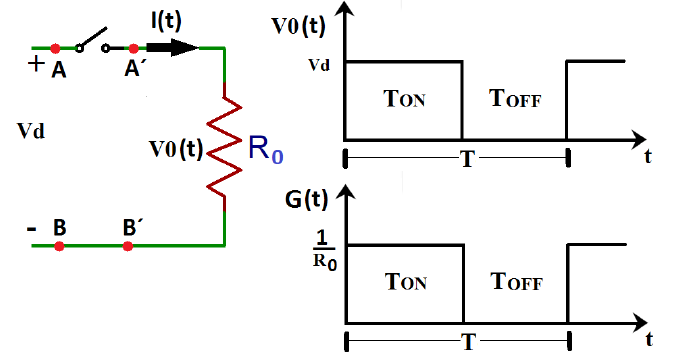
Figure 1. Buck converter.